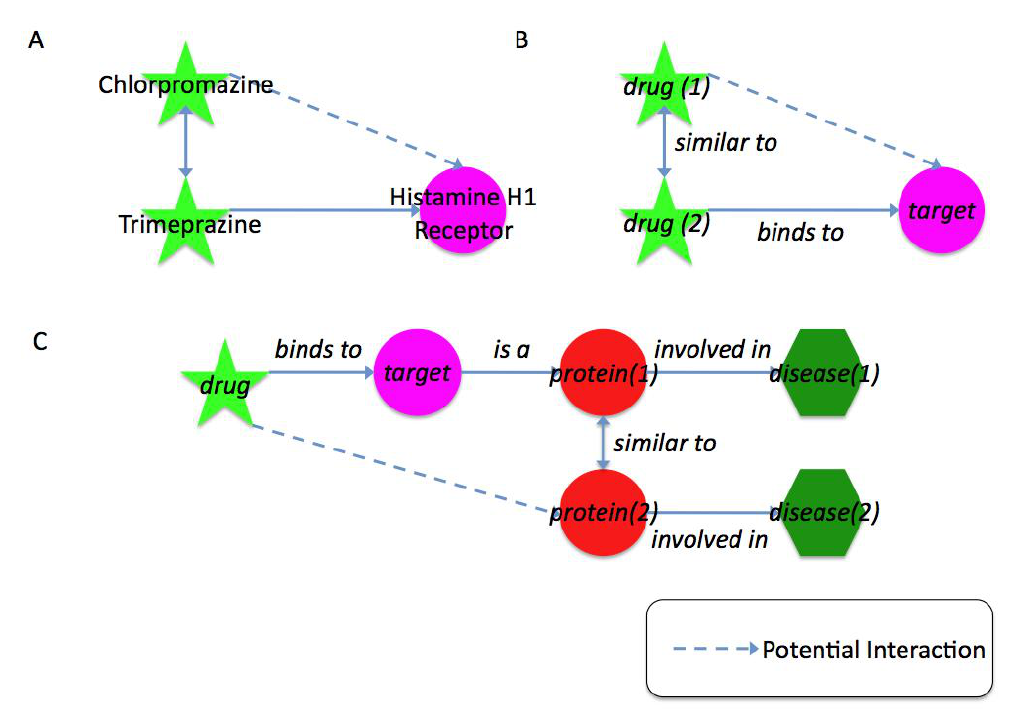
Figure 4: Semantic motifs of possible interest in the context of the Ondex drug repositioning network. A – An instance of the abstract motif shown in B, that is found in the Ondex subnetwork that explains the repositioning of Chlorpromazine (discussed in section 3.1). B – An abstract representation of the semantic motif, of which A is the archetype. C – An abstract semantic motif that implicates a drug as having an impact on a disease(2) , due to the similarity between two proteins involved in separate disease